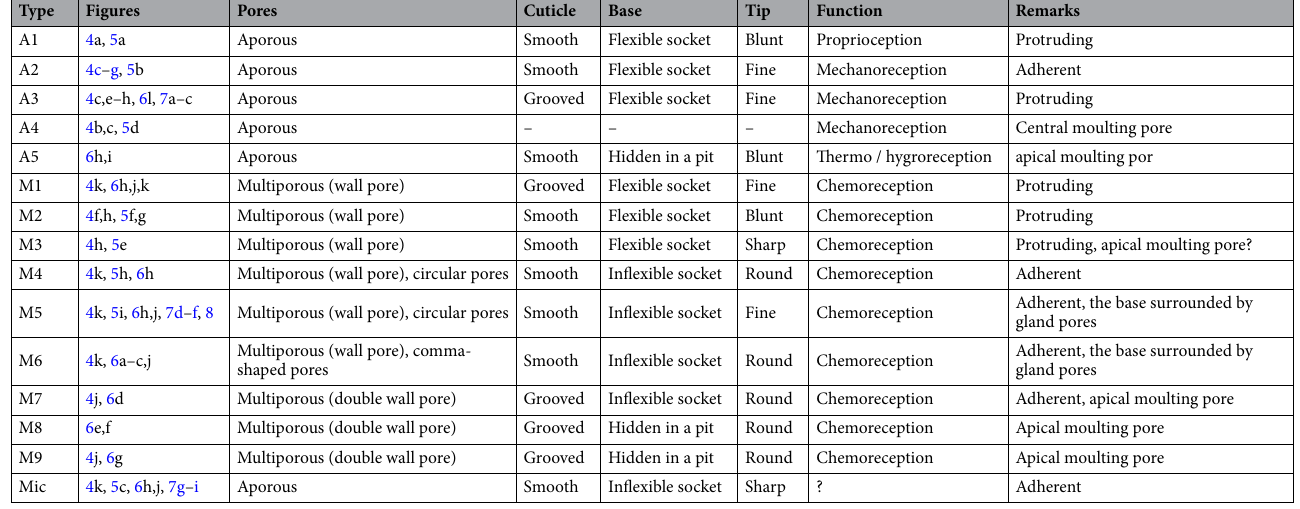
Table 1. Characteristics of the identified types of sensory